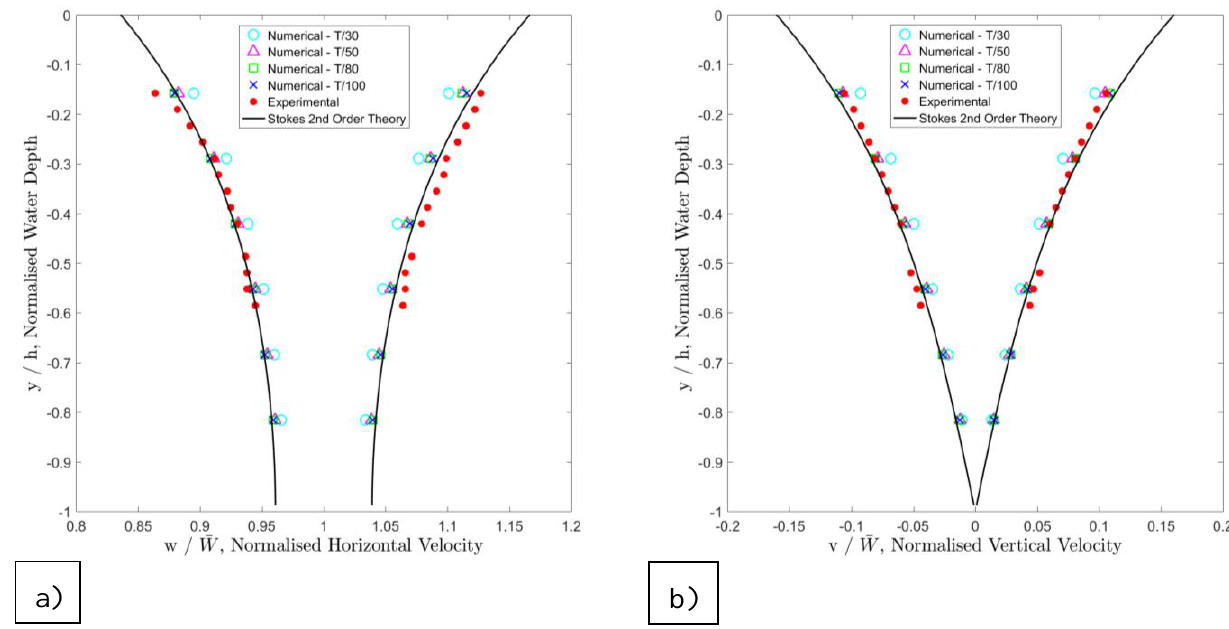
Figure 9. Normalized results for the numerical, theoretical and experimental maximum and minimum wave-induced: (a) horizontal and; (b) vertical velocities for different time steps.